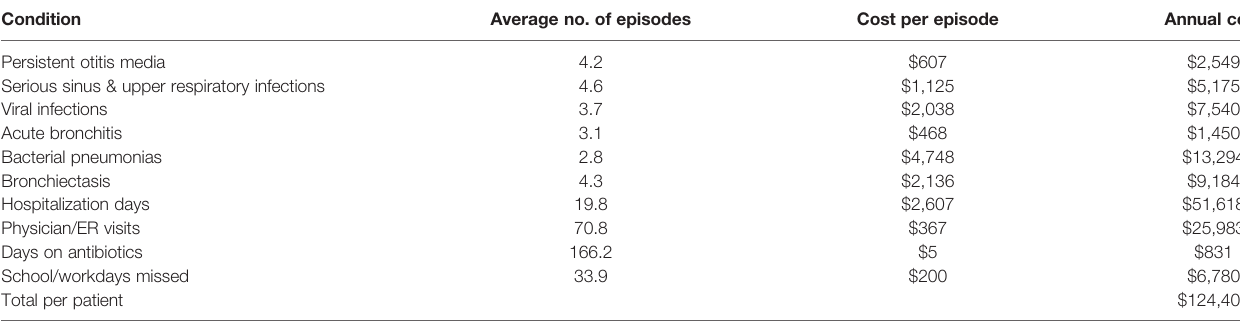
The average number of episodes of each condition is listed in the second column. The estimated cost per episode and the associated total annual cost are listed in the third and fourth columns. The total annual cost per patient is shown in the bottom row of the fourth column. All costs are US